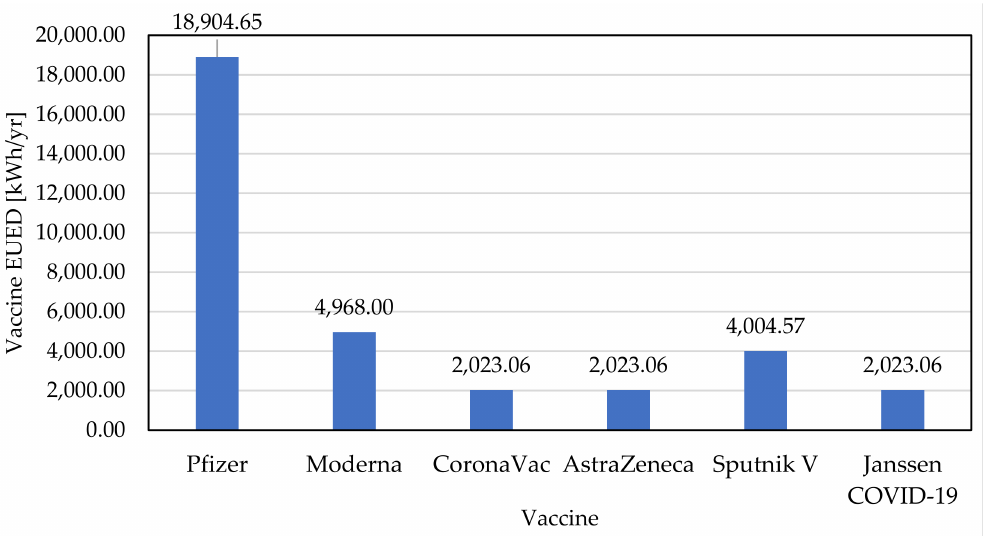
Figure 3. Vaccine Energy Usage Effectiveness Design (EUED)